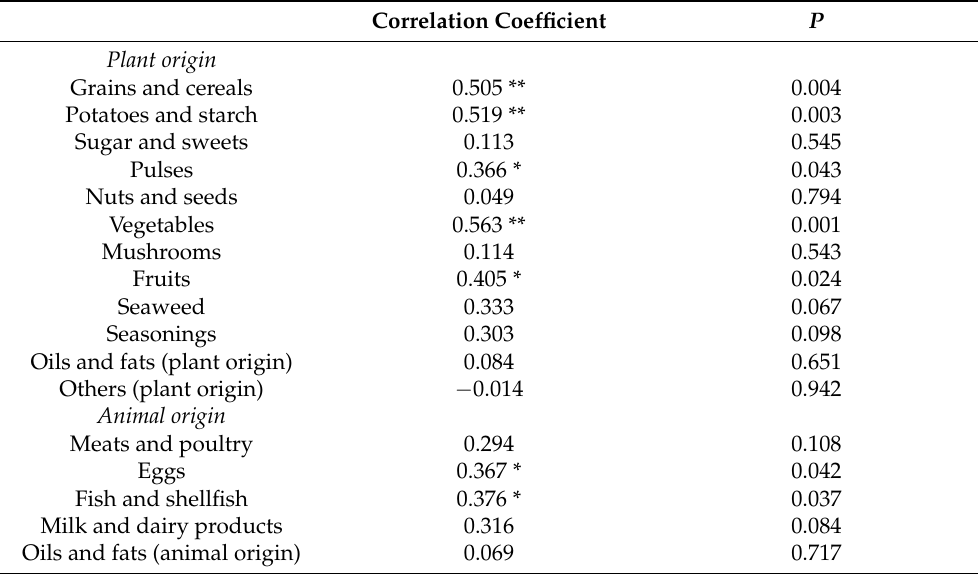
Table 2. Pearson’s coefficients of correlation between blood Cd concentrations and food groups based on the survey site (N: